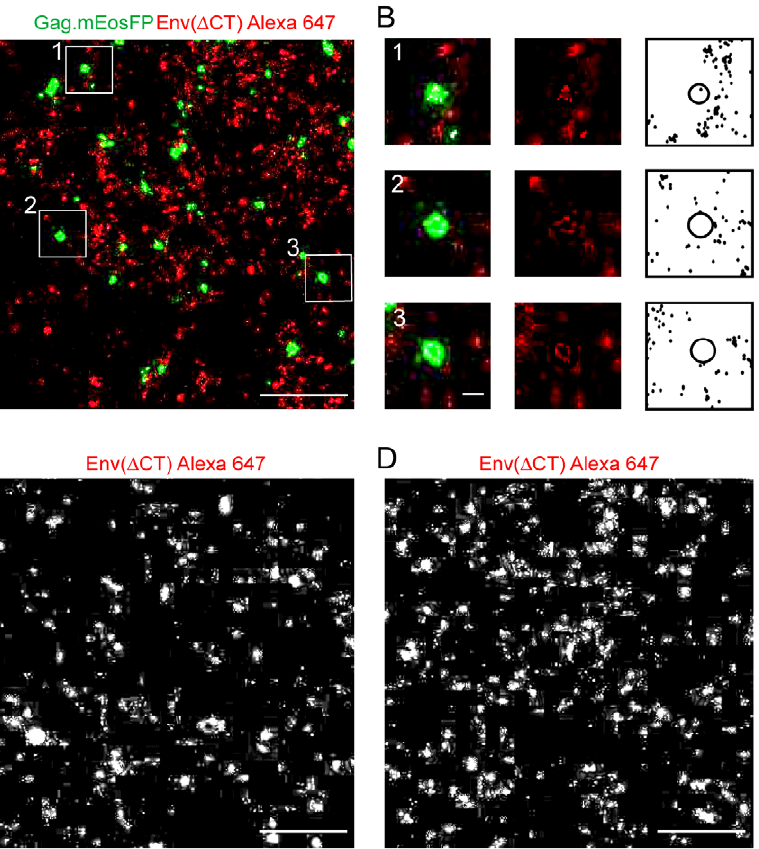
Figure 4. Comparative analysis of Env( D CT) distribution expressed in the viral context or alone. ( A, B ) Distribution of HIV-1 Gag and Env at the plasma membrane of HeLa cells transfected with equimolar amounts of pCHIV.Env( D CT) and pCHIV mEosFP . Env( D CT). Unfixed cells were stained by indirect immunofluorescence using Fab 2G12 and Fab goat anti-human Alexa Fluor 647, fixed, and subjected to dual-color super-resolution microscopy as described in Materials and Methods. ( A ) Region from the plasma membrane of a representative cell, showing the superposition of a PALM image for Gag.mEosFP (green) and the corresponding dSTORM image of Env( D CT) stained with Alexa Fluor 647 (red), respectively. Scale bar corresponds to 1 m m. ( B ) Enlargement of three individual assembly sites from the boxed regions indicated in (A). The figure shows merged super- resolution images (left panels), the dSTORM Env Alexa Fluor 647 image (middle panels) and individual Alexa Fluor 647 localizations from all images recorded in the defined area as black dots, with a black circle representing the rims of the Gag cluster (right panels), respectively. Scale bar corresponds to 100 nm. ( C, D ) Comparison of Env( D CT) distribution patterns in the presence (C) and absence (D) of other HIV-1 derived proteins. HeLa cells were transfected with equimolar amounts of pCHIV.Env( D CT) and pCHIV mEosFP Env( D CT) ( C ) or with pEnv( D CT) ( D ), respectively. Unfixed cells were stained with 2G12 Fab and Alexa Fluor 647 Fab, fixed, and visualized by dSTORM as described. Scale bars represent 1 m m.